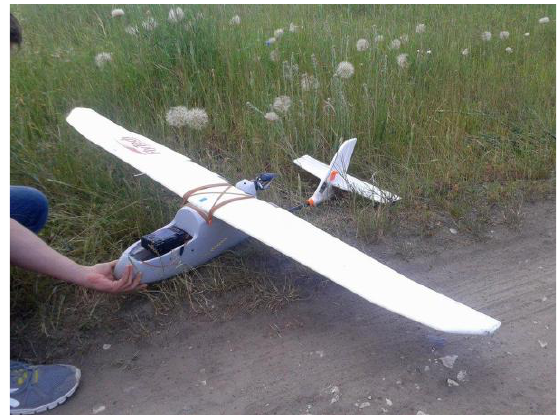
Figure 2. System FT-03A produced by FlyTEch Solutions